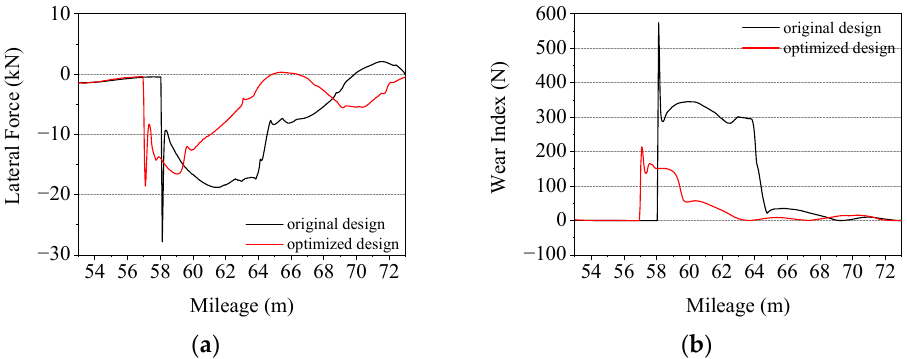
Figure 11. Wheel–rail lateral force, derailment coefficient, and wear index before and after the adjustment of the height reduction of switch rail. ( a ) Lateral force; ( b ) Wear